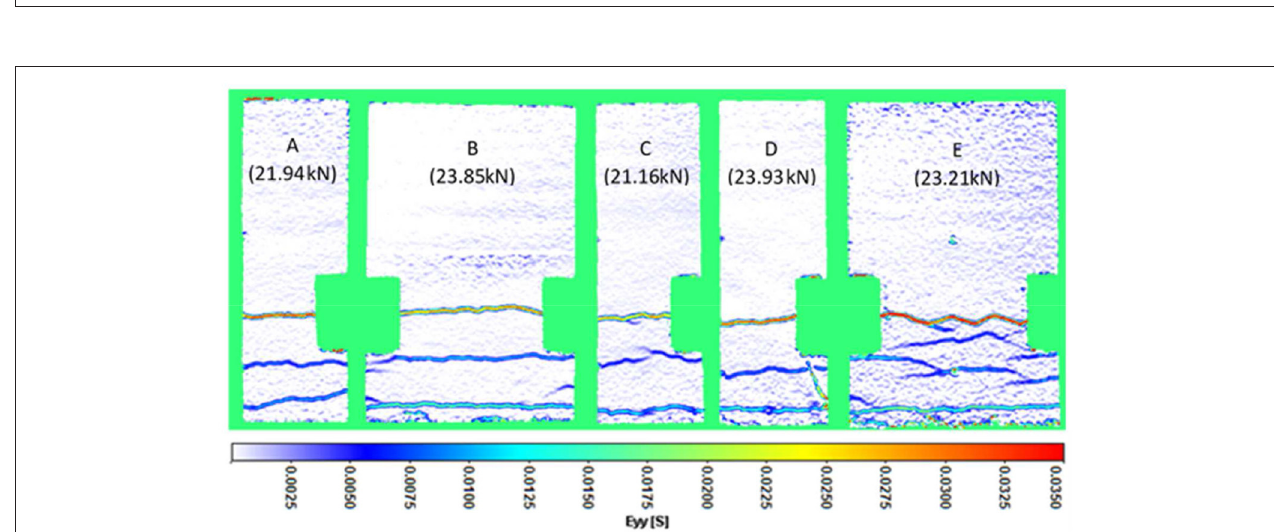
FIGURE 14 | DIC images of all panels at peak load during initial